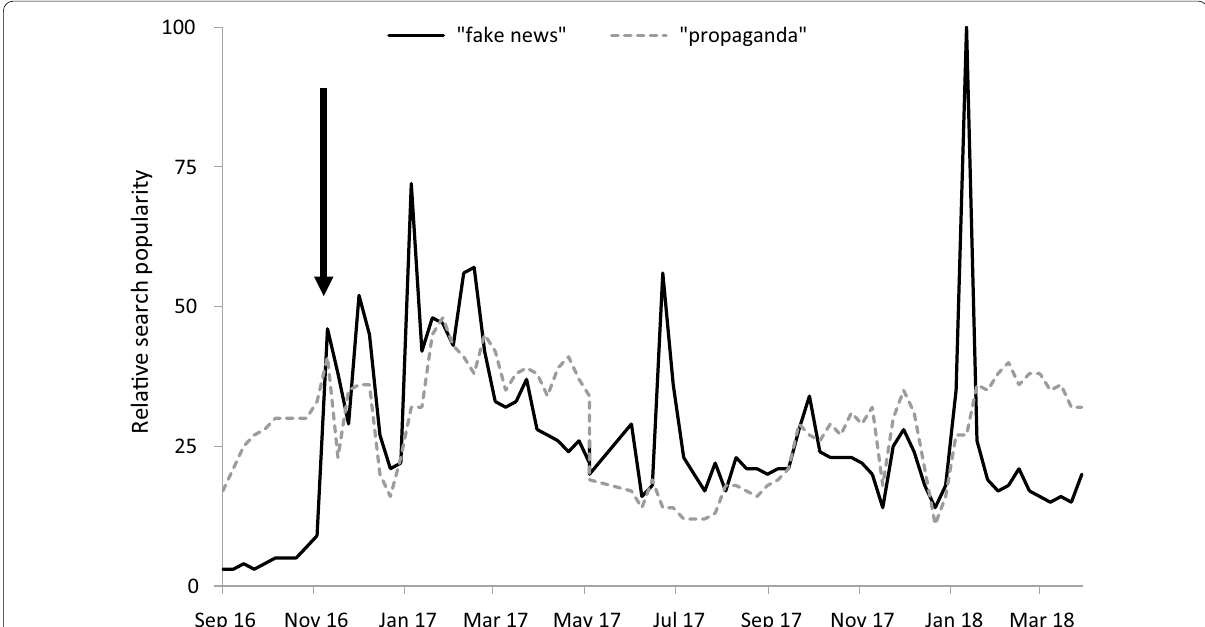
Fig. 1 Google Trends data for the search terms “fake news” and “propaganda.” Searches for “fake news” prior to September 2016 were virtually non‑existent. The arrow highlights the first spike in search popularity around the 2016 US Presidential